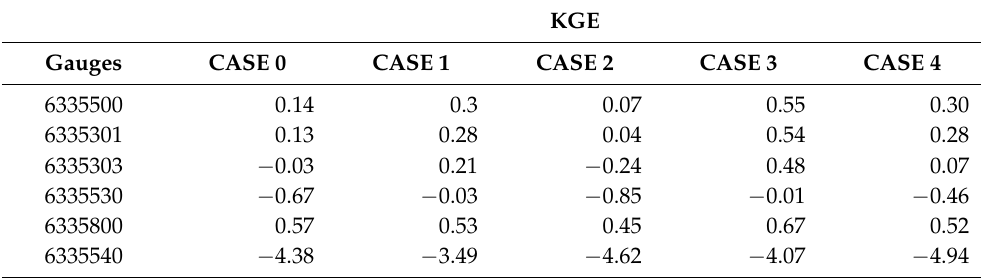
Table 3. Model validation gauges from internal tributaries of the Main